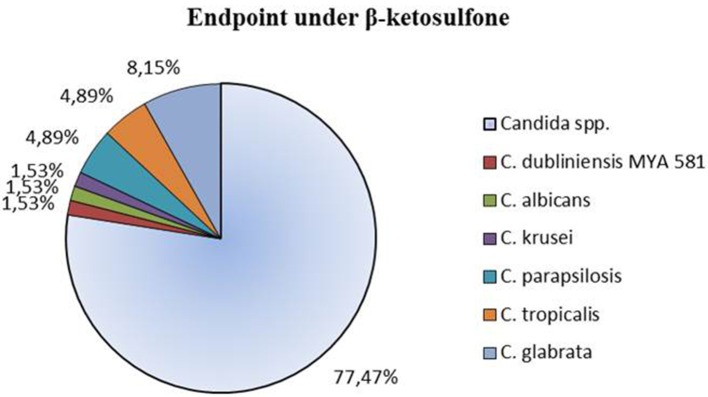
Clear endpoint of the clinical strains of Candida spp. treated with compound 4 (β-ketosulfone) for 48 h in the microdilution assay. Results are expressed as percentages of total number of strains recorded for the antifungal susceptibility profile study. Assays were performed on 2 independent occasions with 3 biological repeats (n = 3).